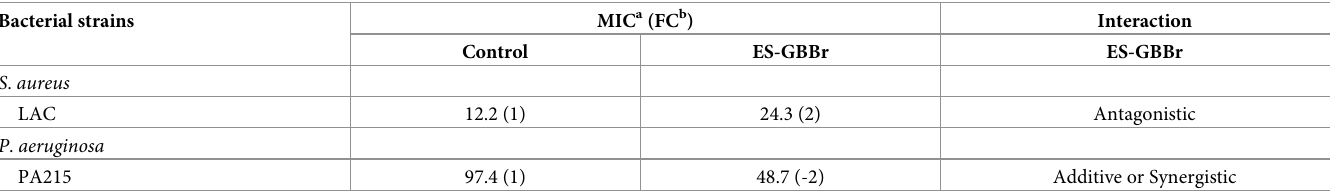
Table 5. Evaluation of conjugative effects within crude ES-GBBr formulation against multi-drug resistant bacterial strains. Bacterial